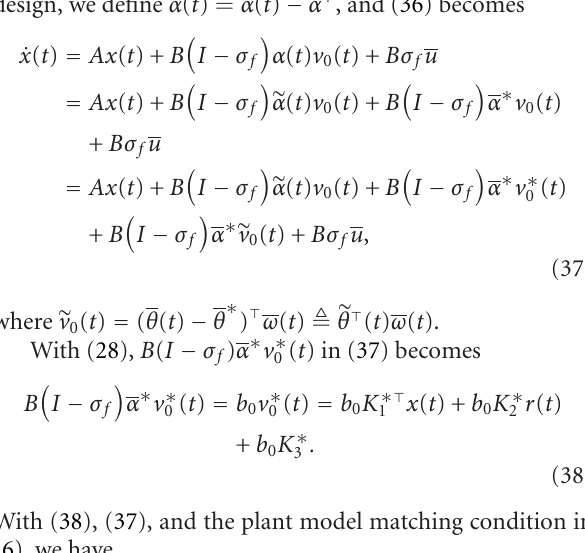
Figure 16: Time history of control signals and actuator